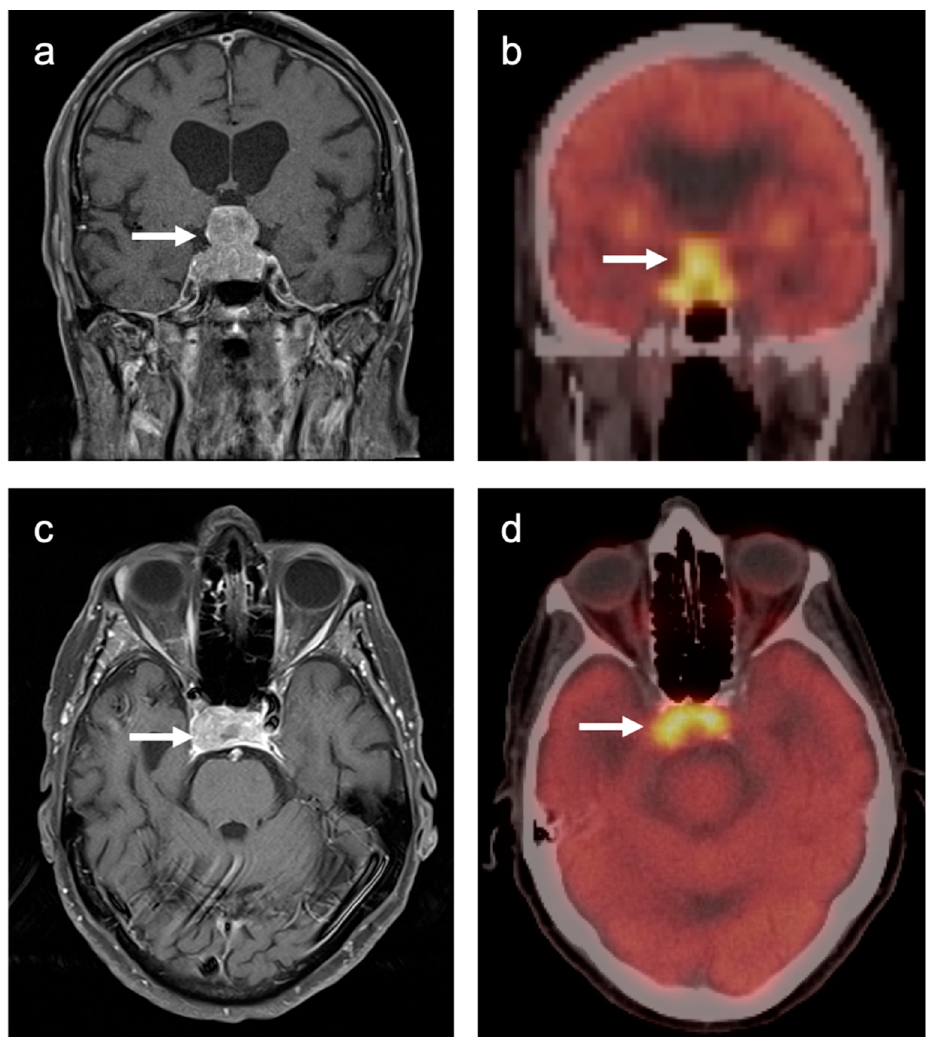
Figure 39. Pituitary macroadenoma. ( a ) Coronal Gd+ T1 MRI and ( b ) coronal FDG PET ‐ CT images demonstrate a sellar ‐ suprasellar hypermetabolic and Gd ‐ enhancing mass (white arrow), unchanged over several years. ( c ) Axial Gd+ T1 MRI and ( d ) axial FDG PET ‐ CT images demonstrate a sellar ‐ suprasellar hypermetabolic and Gd ‐ enhancing mass (white arrow). The patient had a corresponding stable subtle bitemporal hemianopia due to optic chiasm mass effect.